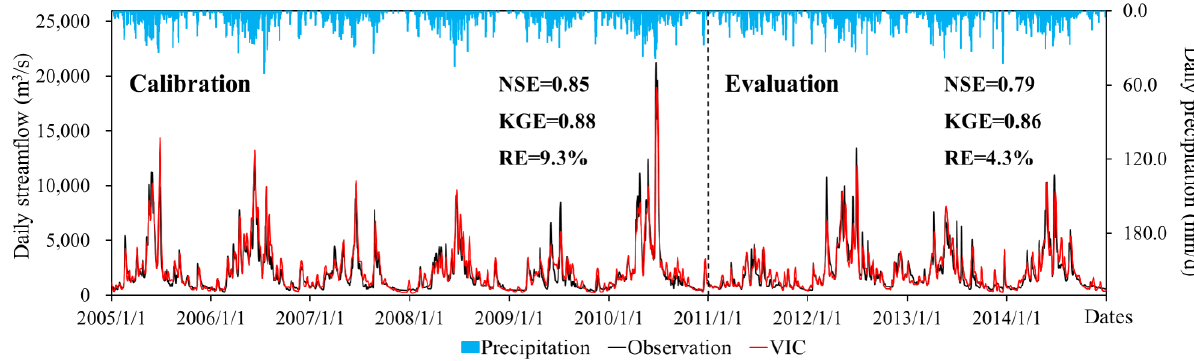
Figure 5. The hydrograph of simulated and observed daily streamflow at the outlet of the GRB.